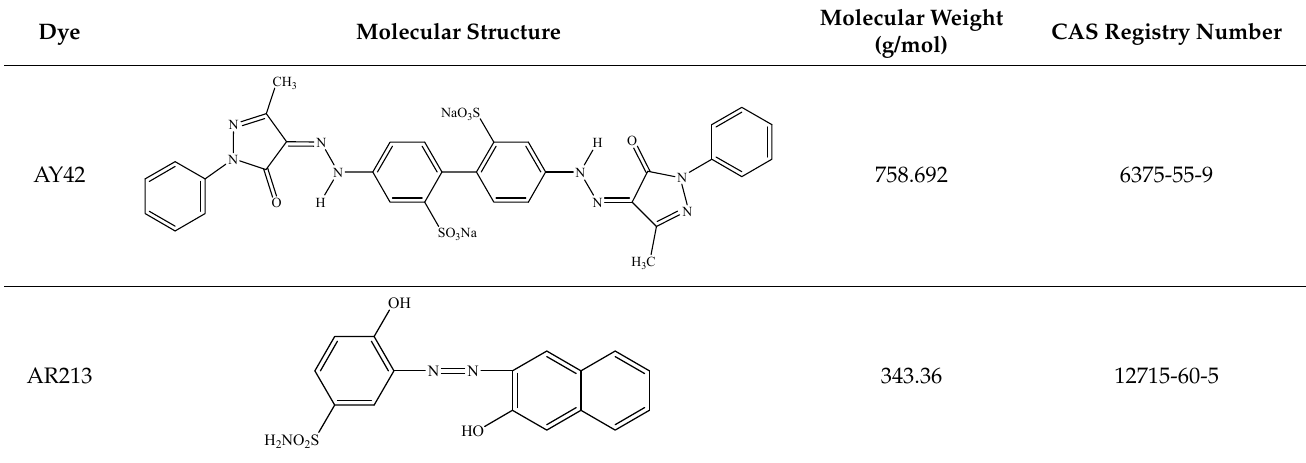
Table 4. The molecular structure and characteristics of the investigated dyes.